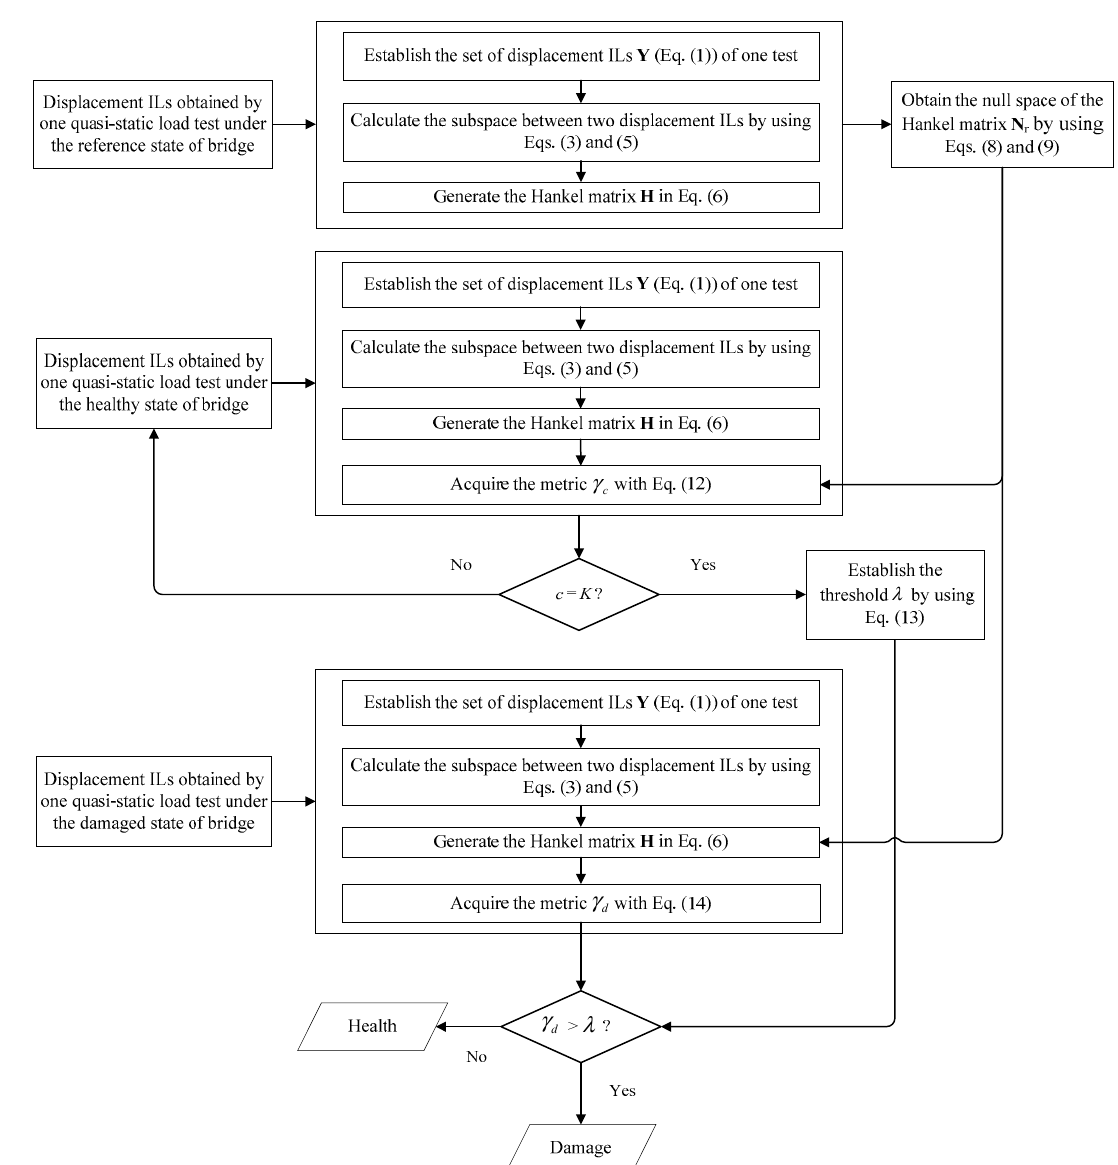
Figure 2. Diagram of the proposed damage detection method.